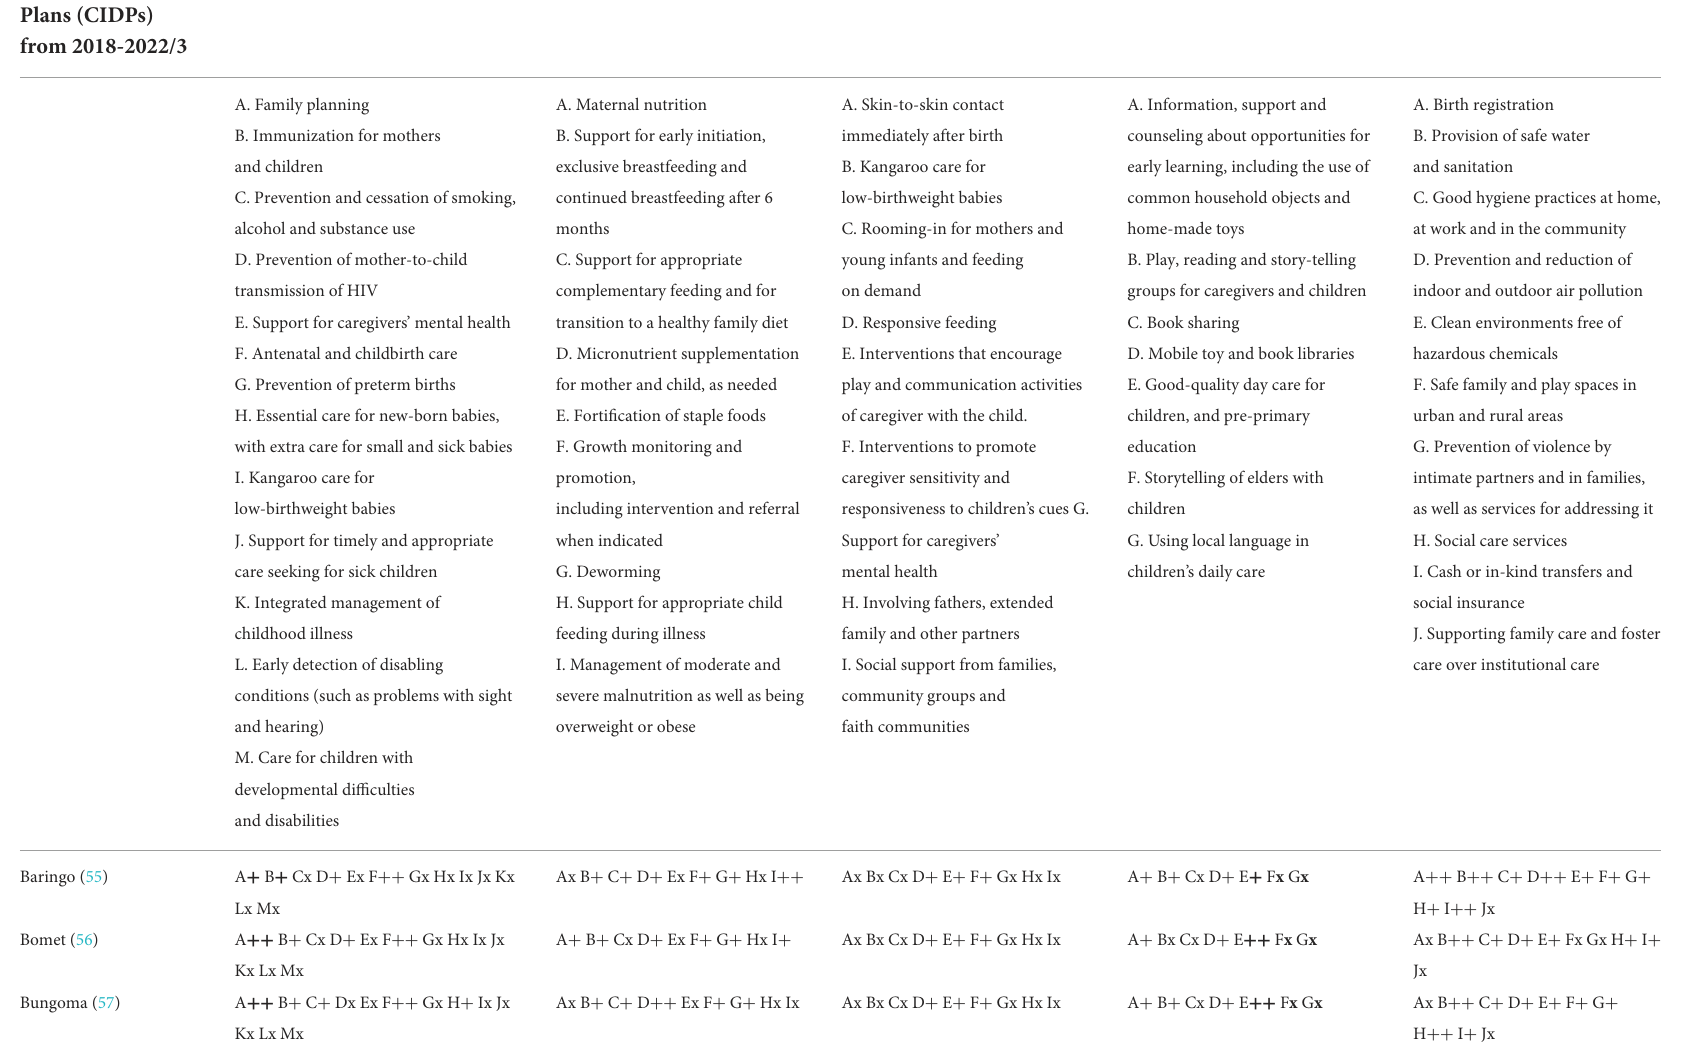
TABLE 3 Data coding for the components of the nurturing care framework as addressed in the Kenyan CIDPs. Kenya’s 47